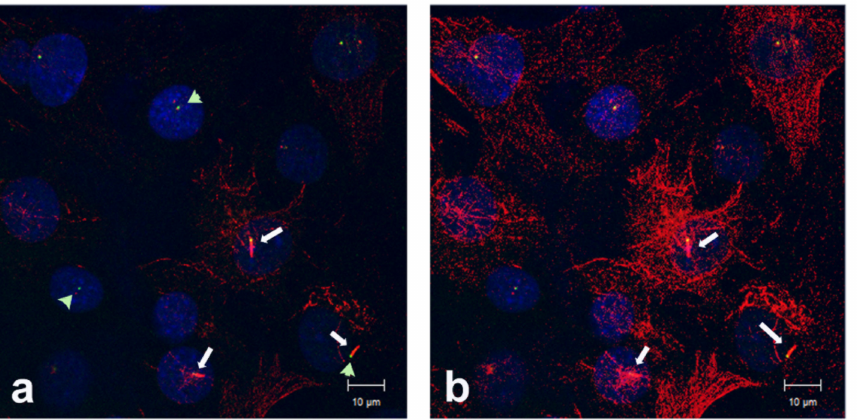
Figure 2. Tubulin acetylation and primary cilia in the NIH3T3 F sub-cell line. Cells were seeded at a density of 2 × 10 5 cells per well, cultivated in normal medium for 24 h, followed by cultivation in exhausted/used medium for another 48 h. Cells were processed for immune cytology using the decoration of acetylated tubulin to identify primary cilia (red, arrows), and ODF2 to highlight the centrosomes and basal bodies (green, arrowheads). Different intensities in ( a ) and ( b ) to demonstrate detection of primary cilia even when cells are highly acetylated. Bars: 10 µ